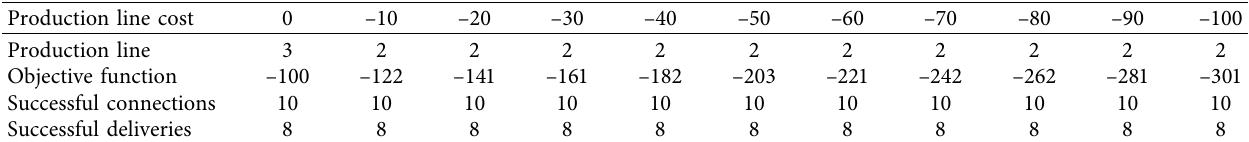
Table 7: Changes in objective function values under different